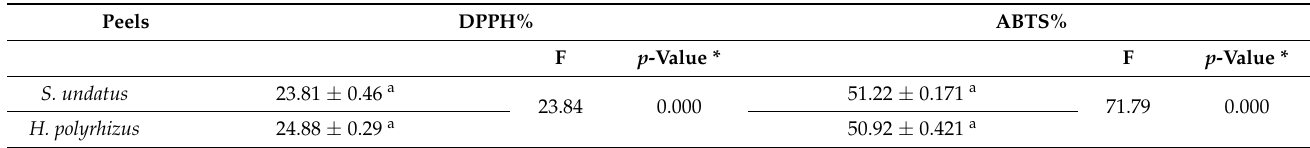
Table 3. Antioxidant capability in methanol extracts of peels in Selenicerus undatus and Hylocereus polyrhizus